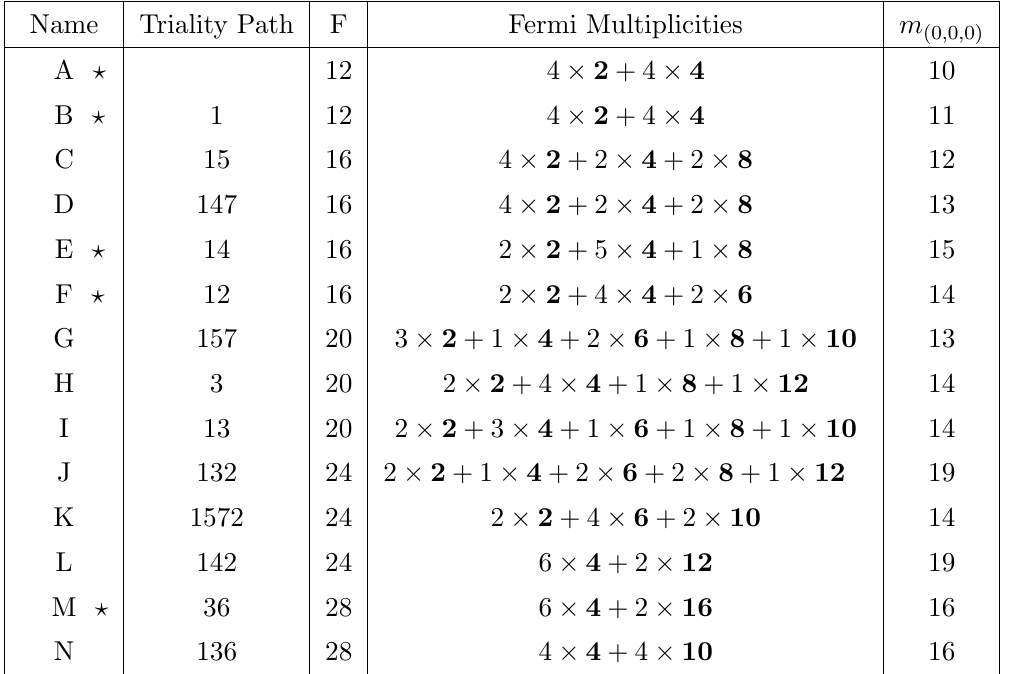
Table 3. Basic information regarding the 14 toric phases of Q 1 ; 1 ; 1 = Z 2